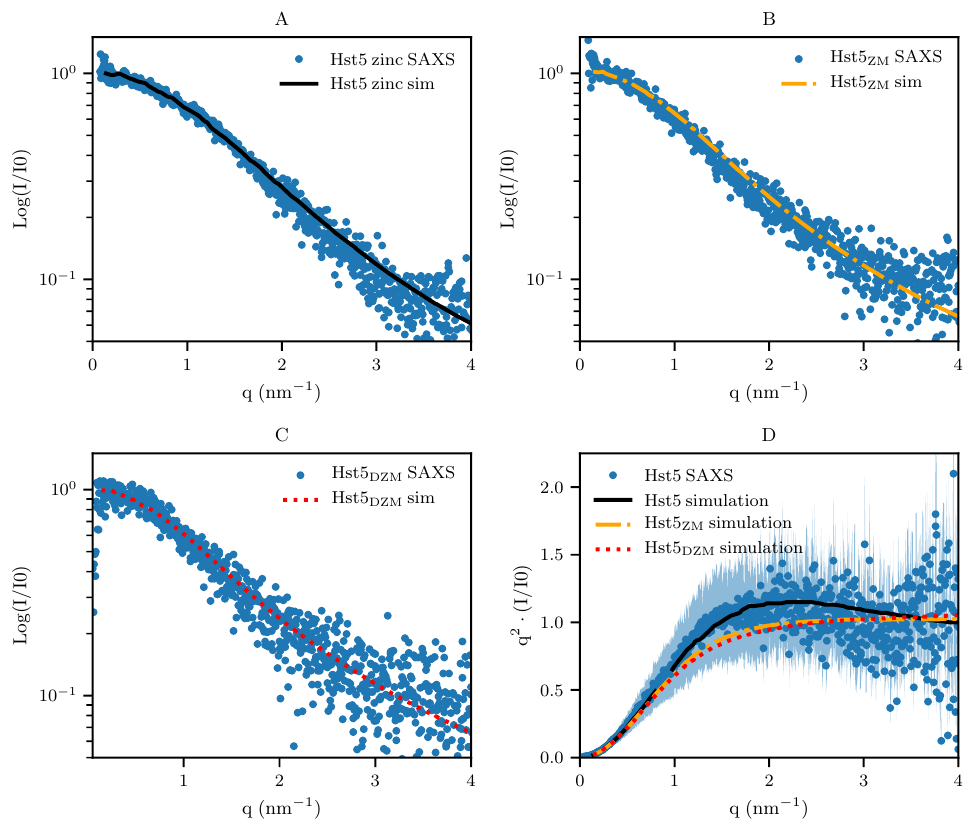
Figure 8. Comparison of experimental SAXS curves with those determined by computer simulation for WT Hst5 . The intensity function normalised by concentration, I ( q ) / c , and the corresponding Kratky plot, q 2 I ( q ) / I ( 0 ) , for SAXS of Hst5 and Monte Carlo simulations, where Figures ( A – C ) depict a comparison between the experimental SAXS-spectra of Hst5/variants and simulations, where the additional short-ranged attractive interactions is taken into consideration. The χ 2 of the fits to the data are as follows ( A ) 2.2 ( B ) 1.9 and ( C ) 1.7. Figure D shows the SAXS data as a Kratky plot. Colours as